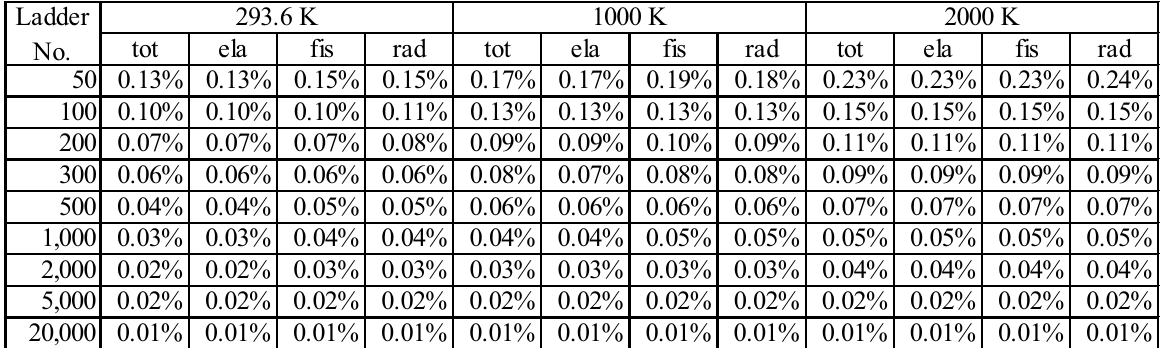
Table I. RMS values of probability table difference in each ladder number ( 235 U).